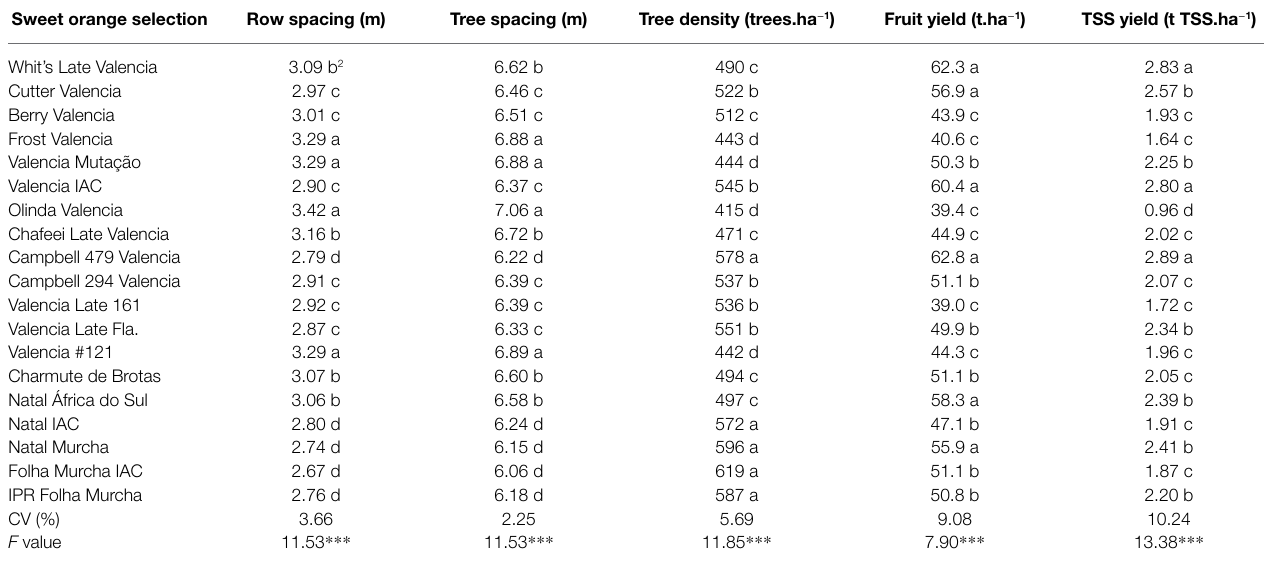
TABLE 6 | Estimates 1 of minimum row and tree spacing, maximum tree density, fruit yield, and TSS yield for 19 late-season sweet orange selections grafted onto Rangpur lime rootstock, based on field performance in Guairaçá, state of Paraná, Brazil. Sweet orange selection